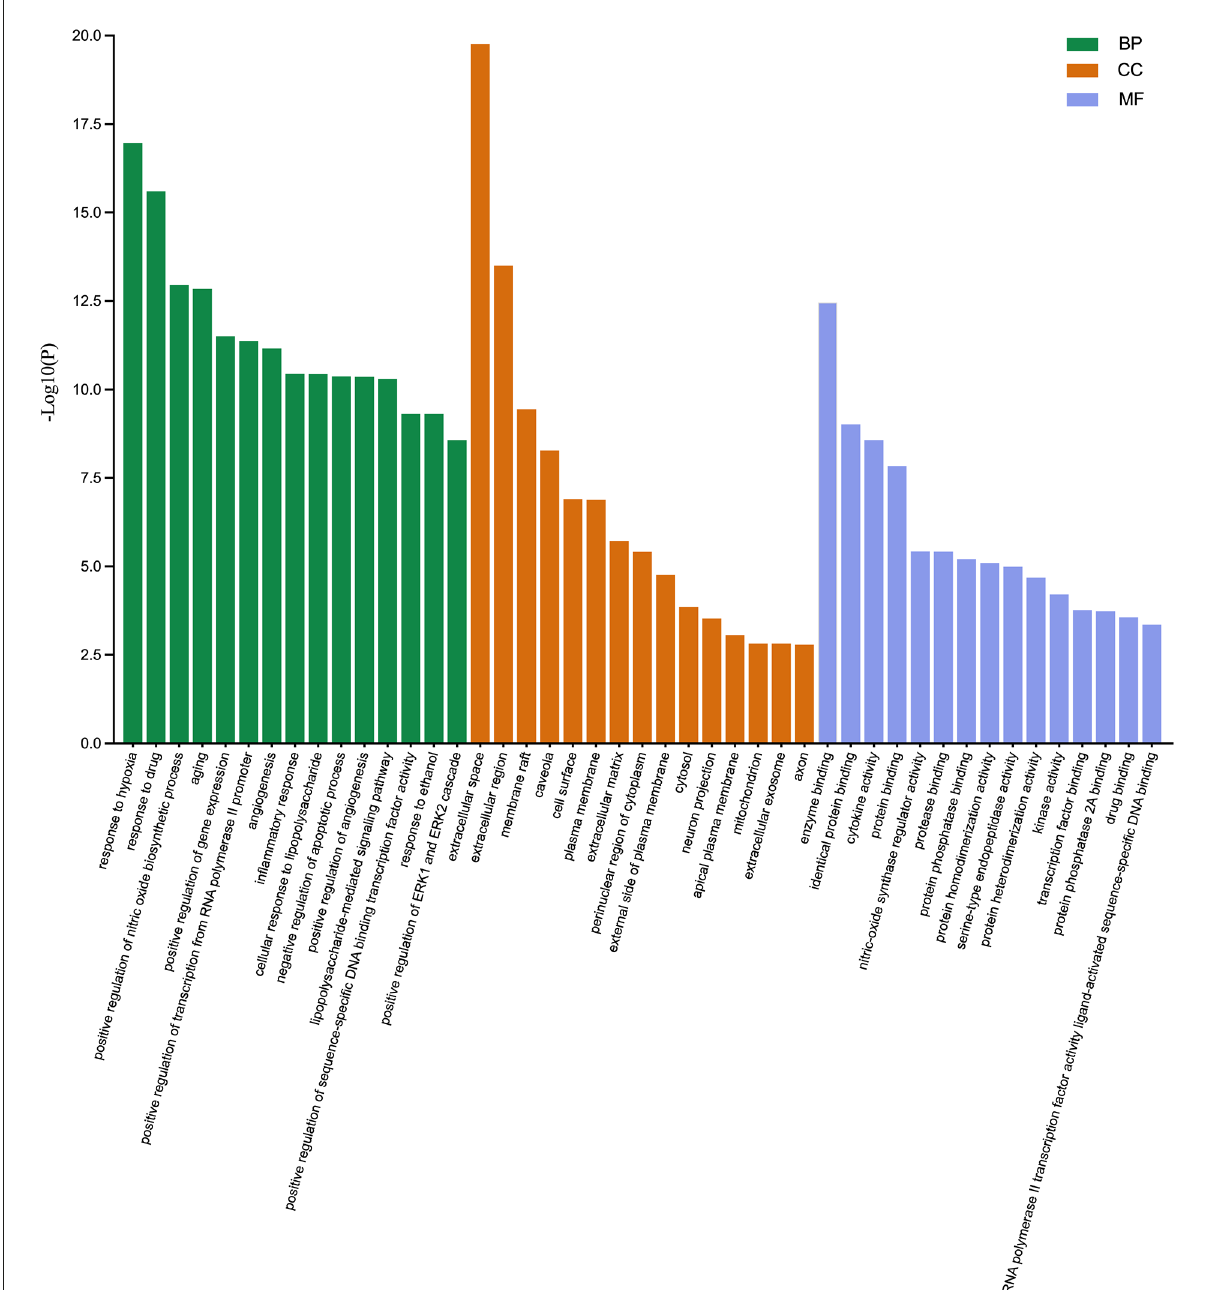
FIGURE3 Gene ontology enrichment analysis. The biological process (BP), cellular component (CC), and molecular function (MF) terms identified by GO enrichment analysis are presented by a two-dimensional bar chart according to the − log10(P) value.